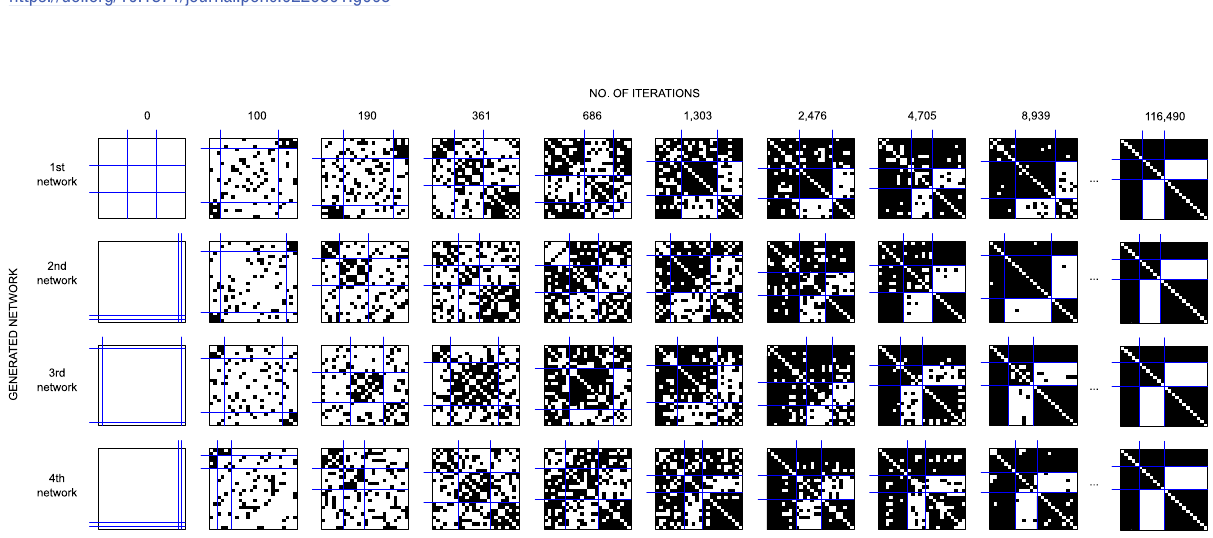
Fig 6. Some networks generated. The networks are generated by considering θ = { M = − 0.18, P = 0.74, A = 0.37, T = − 0.35, OSP = 0.42}, q = 5/9, d 0 = 0. The networks are drawn in line with the blockmodels obtained by generalized blockmodeling (non-specified model). Networks for different repetitions of the algorithm for generating networks are drawn in lines for different numbers of